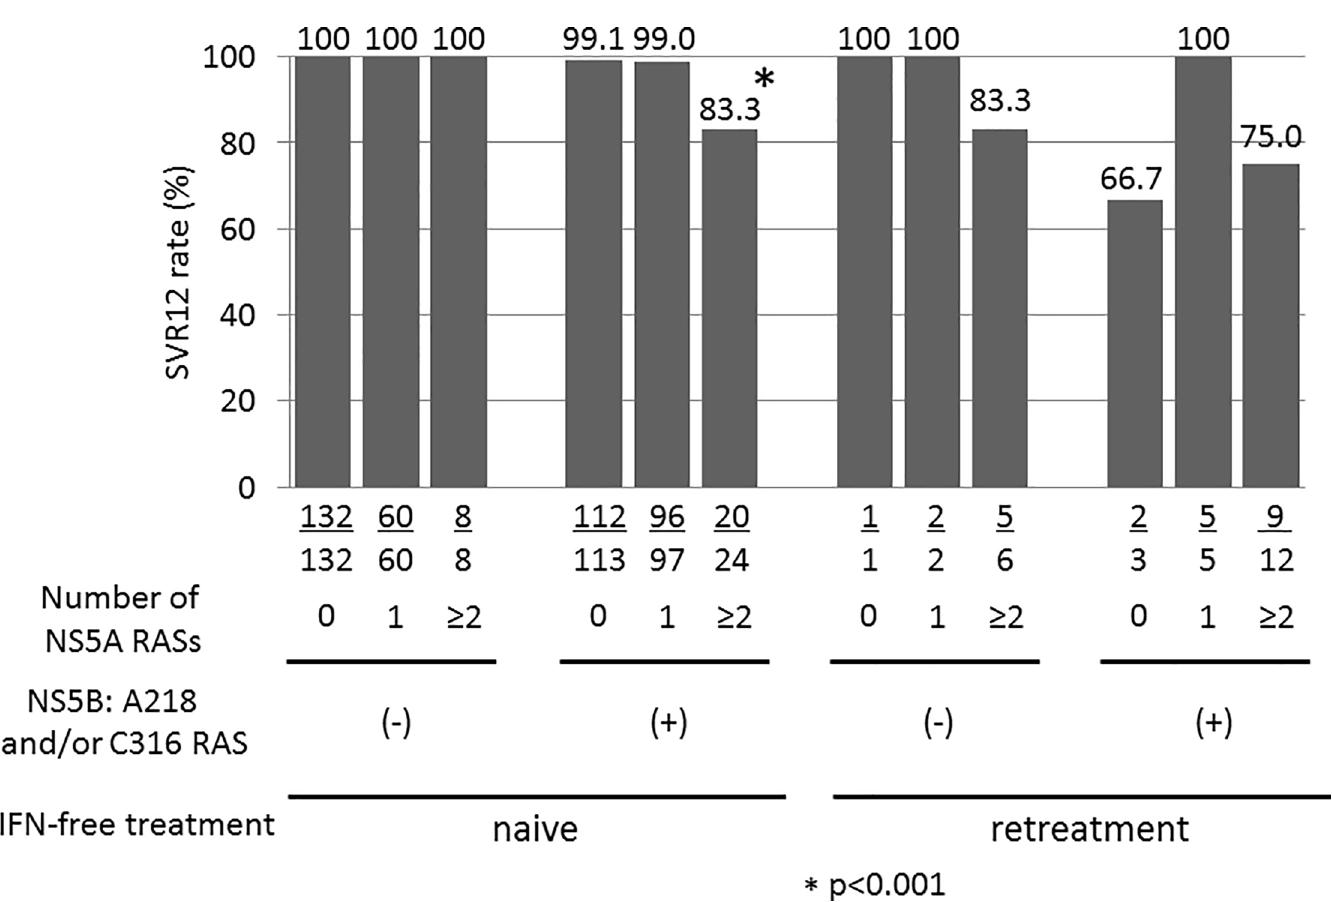
Fig 2. The sustained virologic response (SVR) 12 rate in the patients with co-existing NS5A and NS5B RASs. The interferon (IFN) free-na ï ve patients with coexisting resistance-associated substitutions (RASs) of Q24, L28, and/or R30, L31, or Y93 and NS5B A218 and/or C316 had a significantly lower sustained virologic response (SVR) 12 rate in comparison to the patients without these RASs.